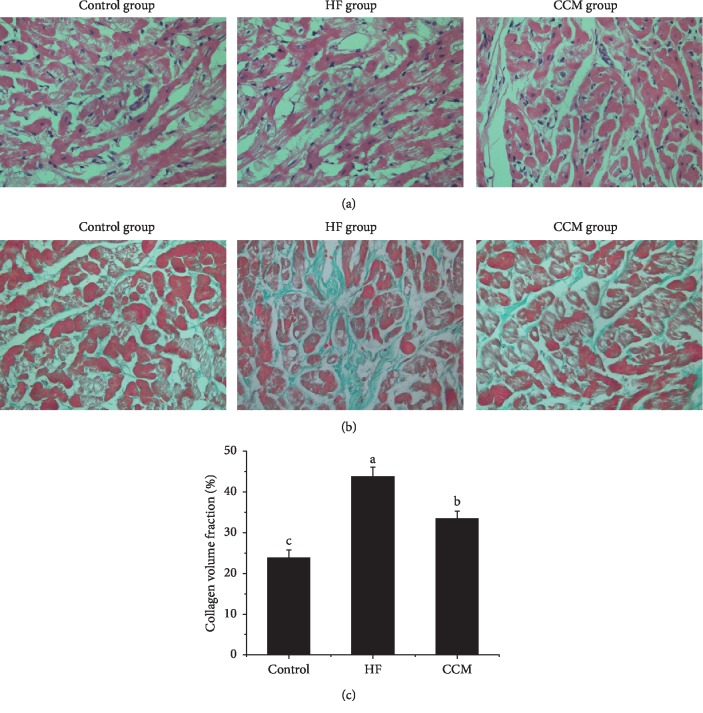
Effects of cardiac contractility modulation (CCM) on myocardial histological changes (a) and (b) microphotography (400x) of myocardial samples from experimental rabbits. (c) Collagen volume fraction of rabbit myocardial tissues with different treatments. HF, heart failure. Different letters above each boxplot showed the significant differences at p < 0.05.